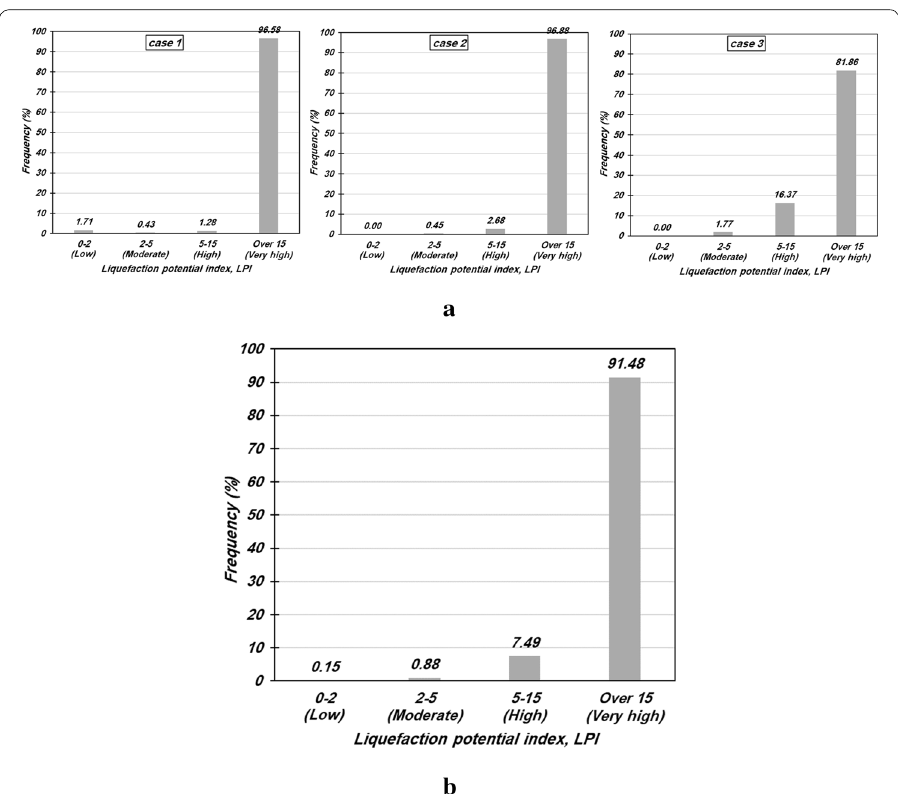
Fig. 9 Histogram of calculated LPI values through Seed and Idriss [1] method for: a cases 1, 2 and 3; and b three